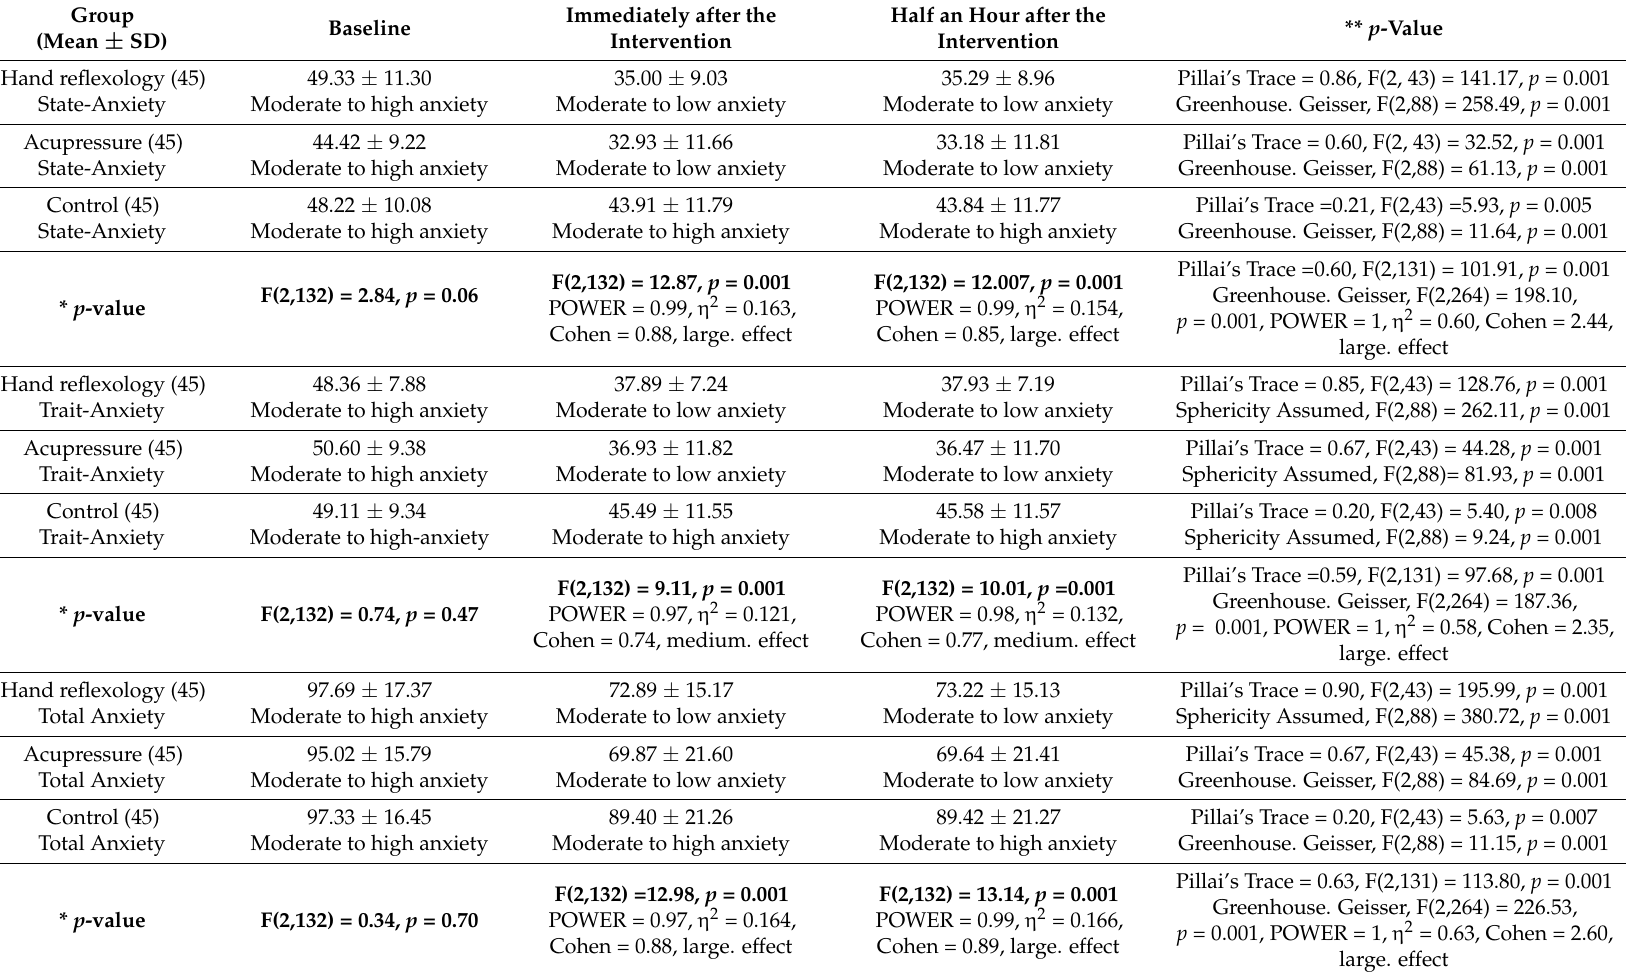
Table 3. Comparison of anxiety before the interventions and at two follow-ups within and between the